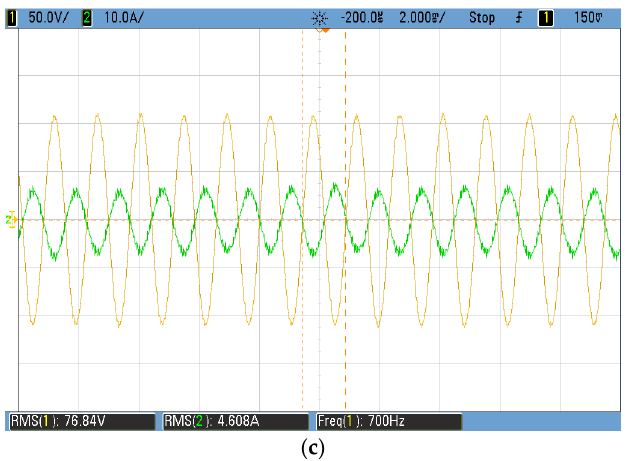
Figure 18. Variable frequency operation in inverter mode ( a ) 360 Hz; ( b ) 400 Hz; and ( c ) 700 Hz.